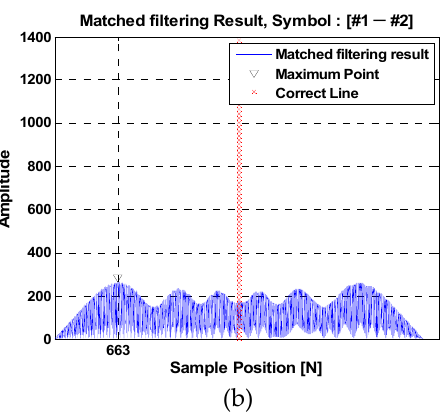
Figure 3. Matched filter output in the same frequency band. ( a ) The same slope symbol; ( b ) different slope symbols.